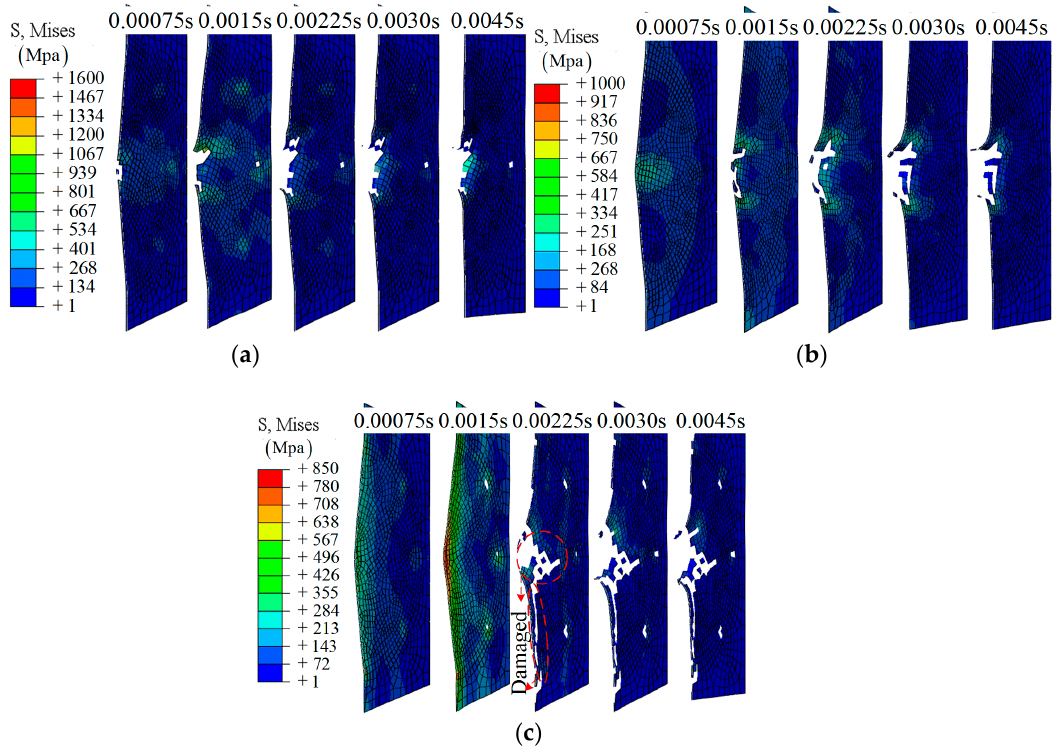
Figure 6. The middle section of different layers during the impact, group A2: ( a ) layer 16; ( b ) layer 8; ( c ) layer 1.